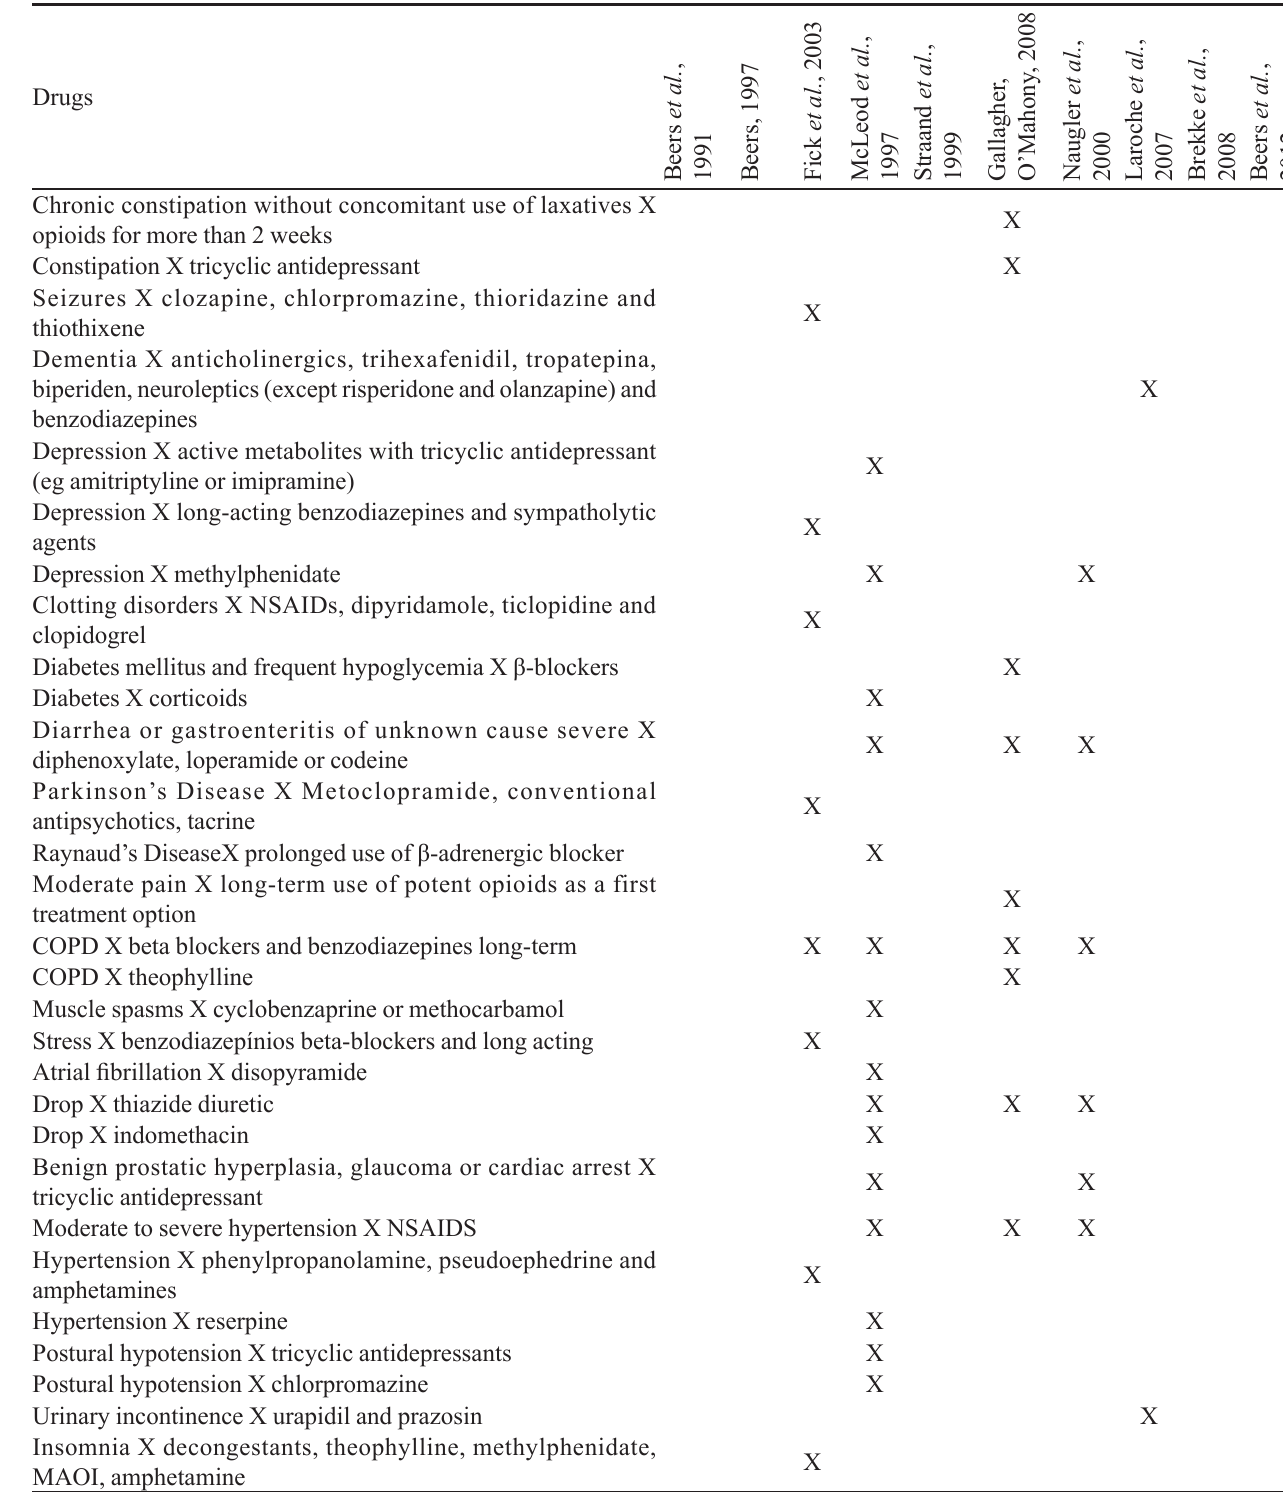
TABLE IV - List of potentially inappropriate medications (PIM) for the elderly that should be avoided as indicated by the clinical diagnosis of the patient (drug interaction with disease), the dose, frequency and duration of the drug administration and drug association, according to the methods identified in PAHO (available at: http://regional.bvsalud.org/php/index.php), Lilacs and Pubmed databases, during the period between February and March 2010 (n=9)